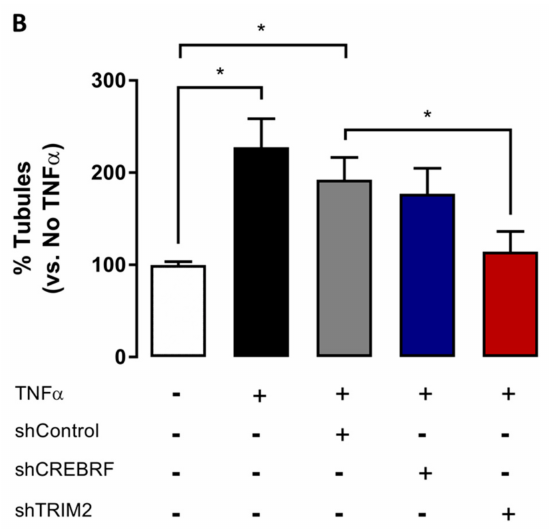
Figure 5. Tubulogenesis following TNF α stimulation in HCAECs transduced with lentivirus containing shControl, shCREBRF or shTRIM2 compared to non-transduced non-TNF α -stimulated cells. ( A ) Representative images of tubule formation were photographed under light microscopy. Scale bars, 50 µ m. ( B ) Number of tubules was counted and analyzed using ImageJ software. Results are mean ± SEM. * p < 0.05 by unpaired two-tailed t